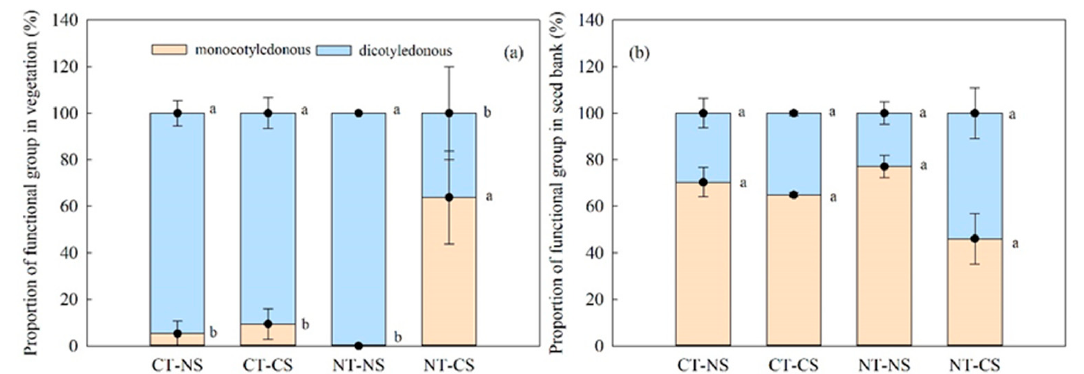
Figure 3. The proportion of functional group in vegetation ( a ) and soil seed bank ( b ) under conventional tillage with no crop residue (CT-NS), conventional tillage with crop residue (CT-CS), no-till with no crop residue (NT-NS), and no-till with crop residue (NT-CS). Different letters indicate significant difference among treatments (one-way ANOVA, p < 0.05). Bars represent means ±